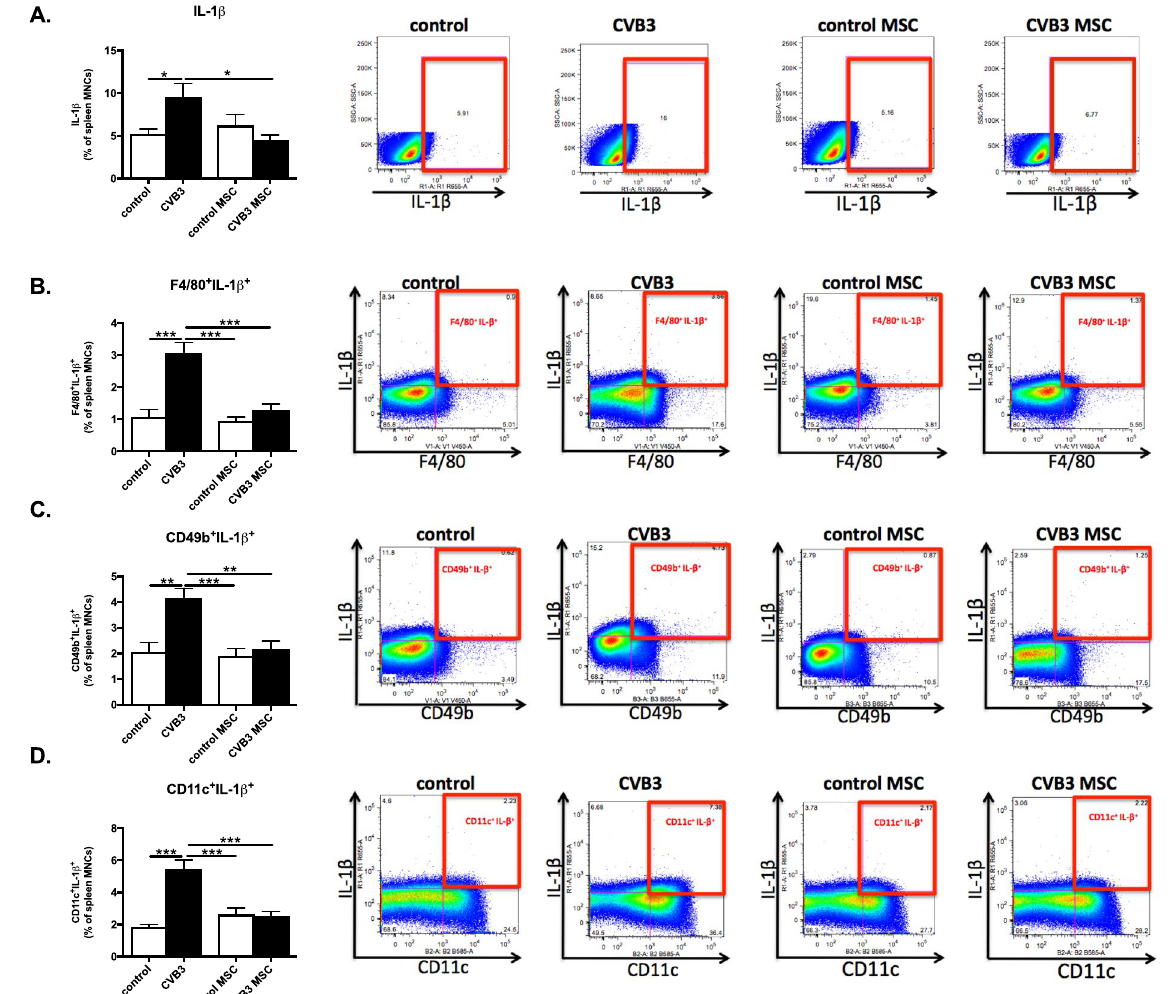
Figure 6. Mesenchymal stromal cells suppress Coxsackievirus B3-induced IL-1 β secretion by macrophages, natural killer cells, and dendritic cells. ( A ) Bar graphs represent the mean ± SEM of IL-1 β -positive splenocytes in control mice (open bar) and CVB3-infected mice (closed bar) injected with PBS or MSC, expressed as the percentage of total MNCs, with n = 8–9/group and * p < 0.05. The right panel shows dot plots of IL-1 β -positive splenocytes of control, CVB3, control MSC, and CVB3 MSC mice, as indicated. ( B ) Bar graphs represent the mean ± SEM of F4/80 + /IL-1 β + in control mice (open bar) and CVB3-infected mice (closed bar) injected with PBS or MSC, expressed as the percentage of total MNCs, with n = 8–9/group and *** p < 0.001. The right panel shows dot plots of F4/80 + /IL-1 β + positive splenocytes of control, CVB3, control MSC, and CVB3 MSC mice, as indicated. ( C ) Bar graphs represent the mean ± SEM of CD49b + /IL-1 β + in control mice (open bar) and CVB3-infected mice (closed bar) injected with PBS or MSC, expressed as the percentage of total MNCs, with n = 8–9/group, ** p < 0.01 and *** p < 0.001. The right panel shows dot plots of CD49b + /IL-1 β + positive splenocytes of control, CVB3, control MSC, and CVB3 MSC mice, as indicated. ( D ) Bar graphs represent the mean ± SEM of CD11c + /IL-1 β + in control mice (open bar) and CVB3-infected mice (closed bar) injected with PBS or MSC, expressed as the percentage of total MNCs, with n = 8–9/group and *** p < 0.001. The right panel shows dot plots of CD11c + /IL-1 β + -positive splenocytes of control, CVB3, control MSC, and CVB3 MSC mice, as